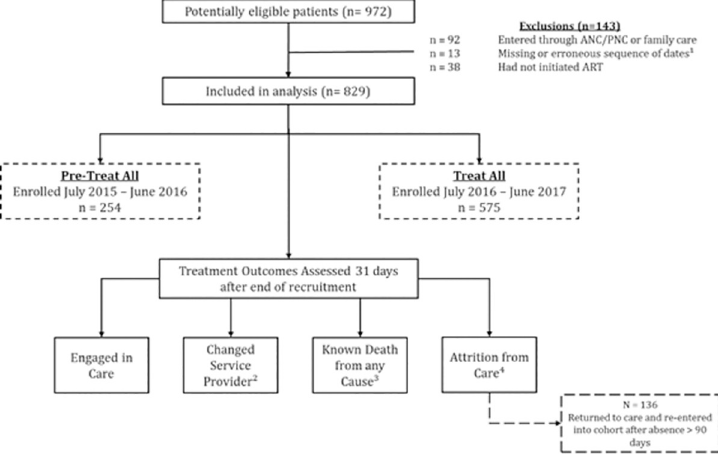
Fig 1. Study flow and treatment outcomes under analysis. 1 Missing treatment initiation date, sequence of dates erroneous and could not be determined reliably, or patients who initiated ART after the follow-up time period. 2 Transferred to health facility outside of study cohort. 3 Mortality from any cause recorded in the medical record. 4 Absence from care greater than 90 days.